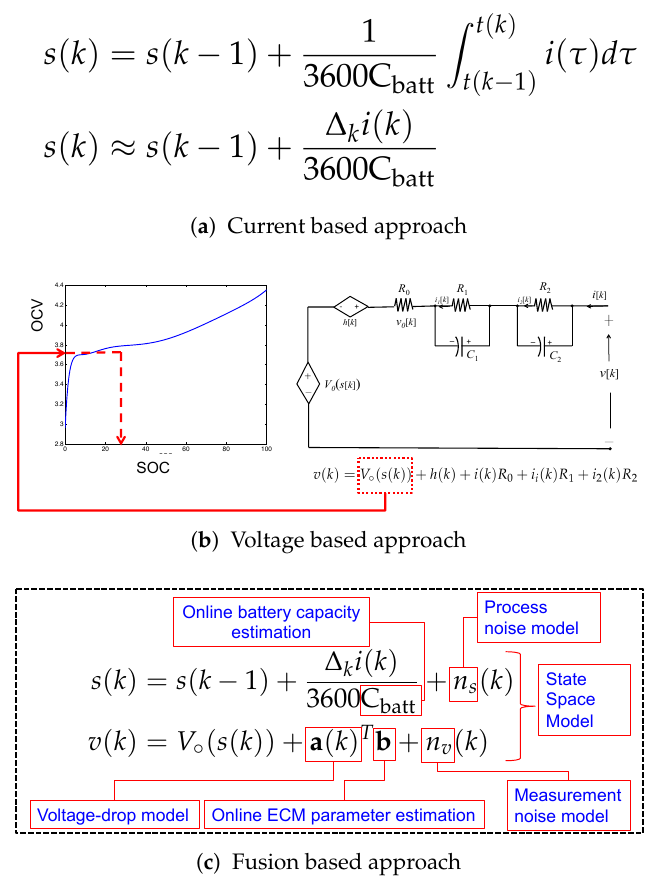
Figure 1. State of charge estimation. The fusion based approach is one of the most robust approaches to accurate battery SOC estimation.